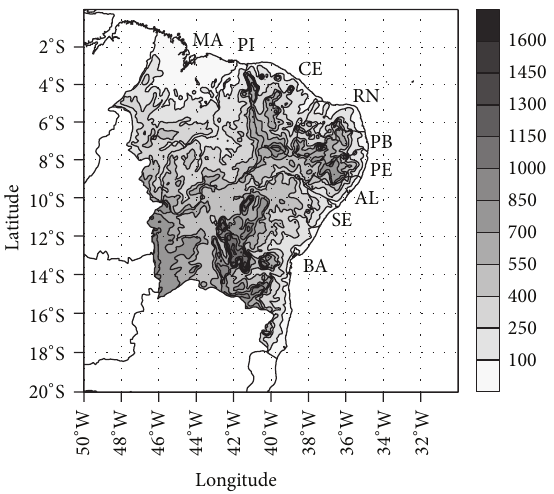
Figure 1: Northeast Brazil geographical location and study area. The orography is depicted by shading